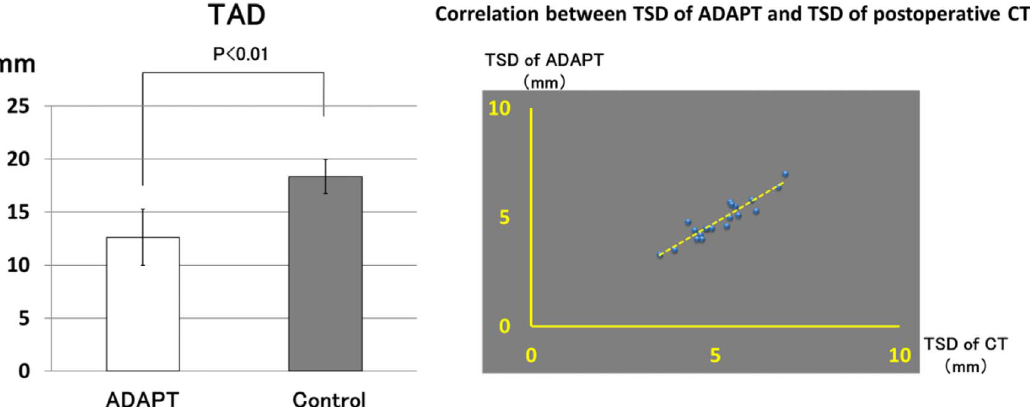
Figure 5. TAD : TAD signi fi cantly better in the ADAPT group. Correlation between TSD of ADAPT and TSD of postoperative CT : The correlation coef fi cient between the two groups is 0.81 ( r = 0.81).